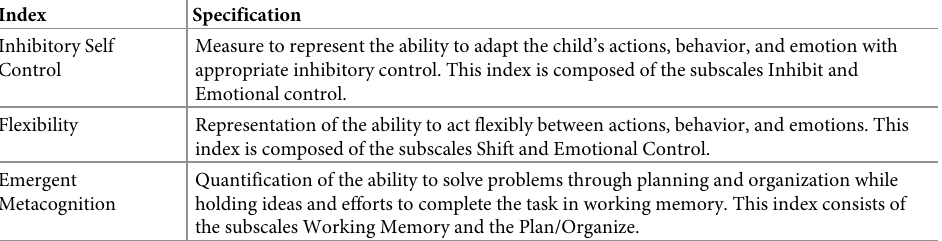
Table 2. Indices of executive function quantified from the BRIEF-P: Inhibitory self control, flexibility and emer- gent metacognition.